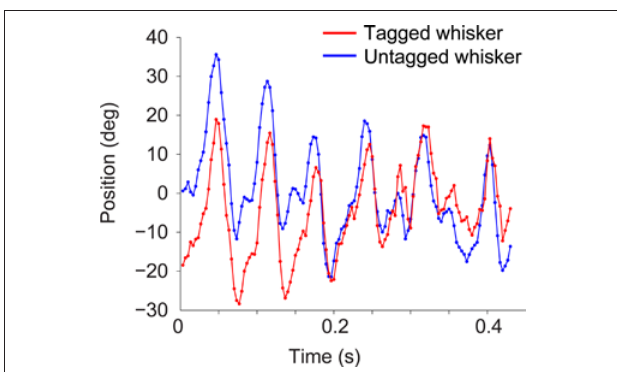
FigurE A1 | Comparison of tagged and untagged whisker motion. The two whiskers were adjacent to each other on the same side of the snout. The tagged whisker was tracked using our automated tracking algorithms. The untagged whisker was tracked manually. As can be seen, the two whiskers’ motion is very similar and the whisking frequency and amplitude appear unaffected by the presence of the tag.